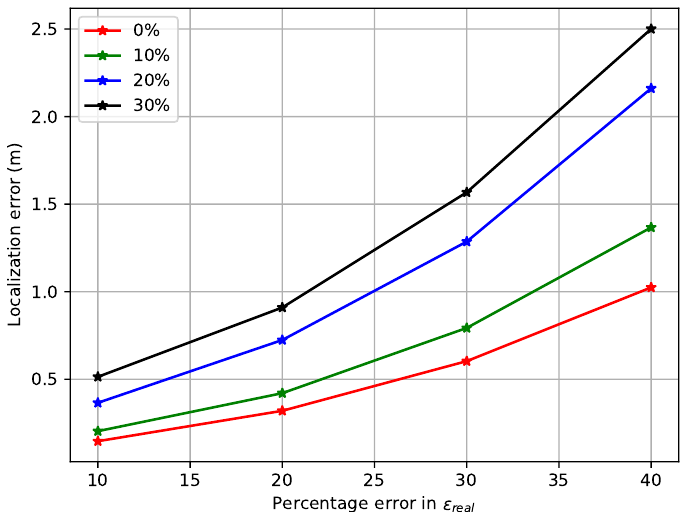
Figure 6. Sensitivity of time of arrival-based localization with respect to (cid:101) (cid:48) s